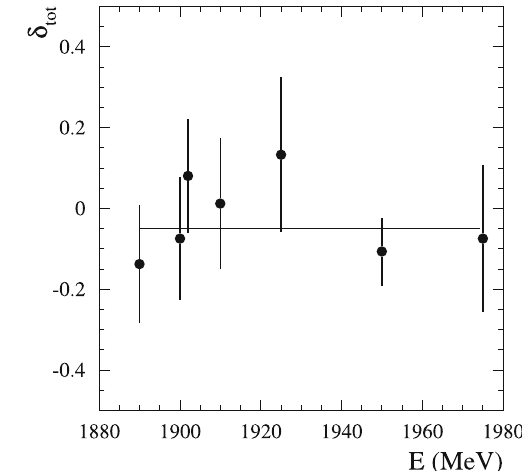
Fig. 11 The energy dependence of the efficiency correction associated with the n ¯ n selection conditions. The line indicates a fit to a constant value